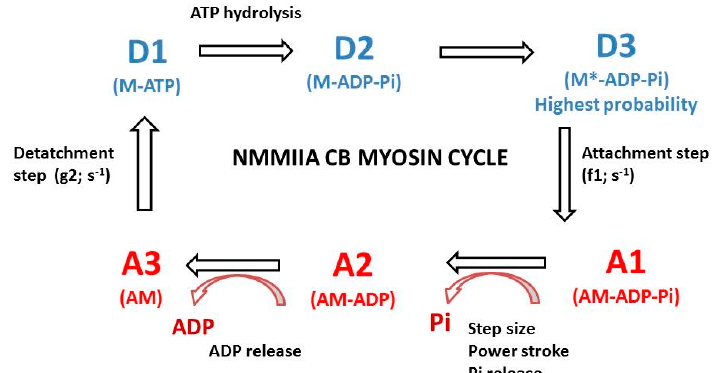
Figure 1. NMMIIA-CB cycle in myofibroblast. The cycle of the non-muscle NMMIIA is composed of six successive conformational steps. Three steps are detached (D1, D2, and D3) and three steps are attached (A1, A2, and A3). (1 ◦ ) Transition A3 → D1. The ATP binding step induces myosin